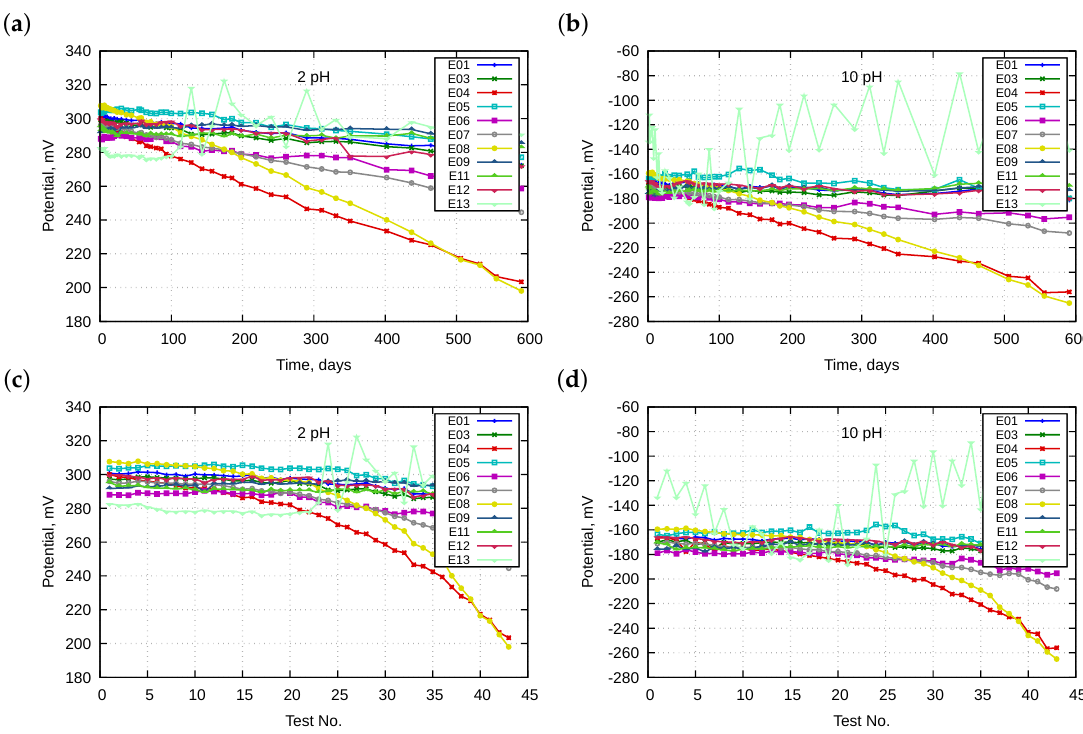
Figure 1. Change of potentials of electrodes E01–E13 in the same buffer solutions: ( a , b ) as a function of time in pH 2 and 10, respectively; and ( c , d ) as a function of the test